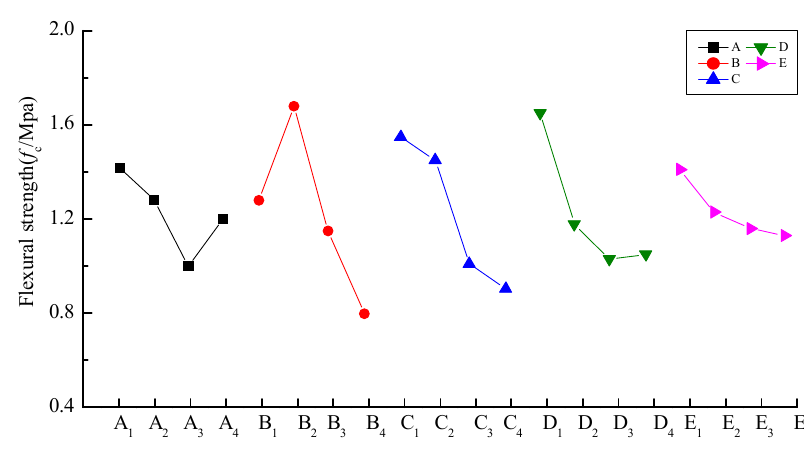
Figure 5. Intuitive analysis of flexural strength.